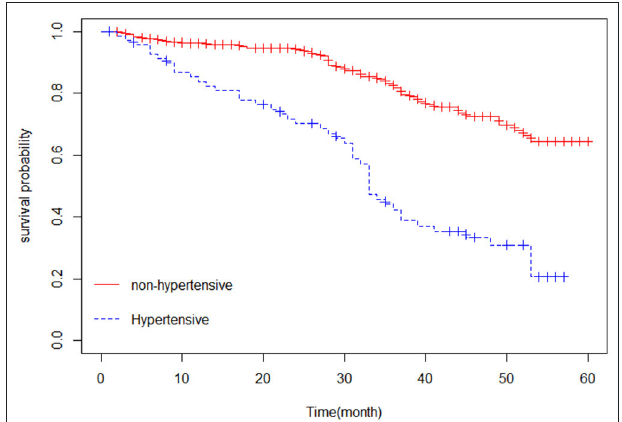
FIGURE 1 | Kaplan-Meier curve of chronic heart failure patients based on hypertension status.